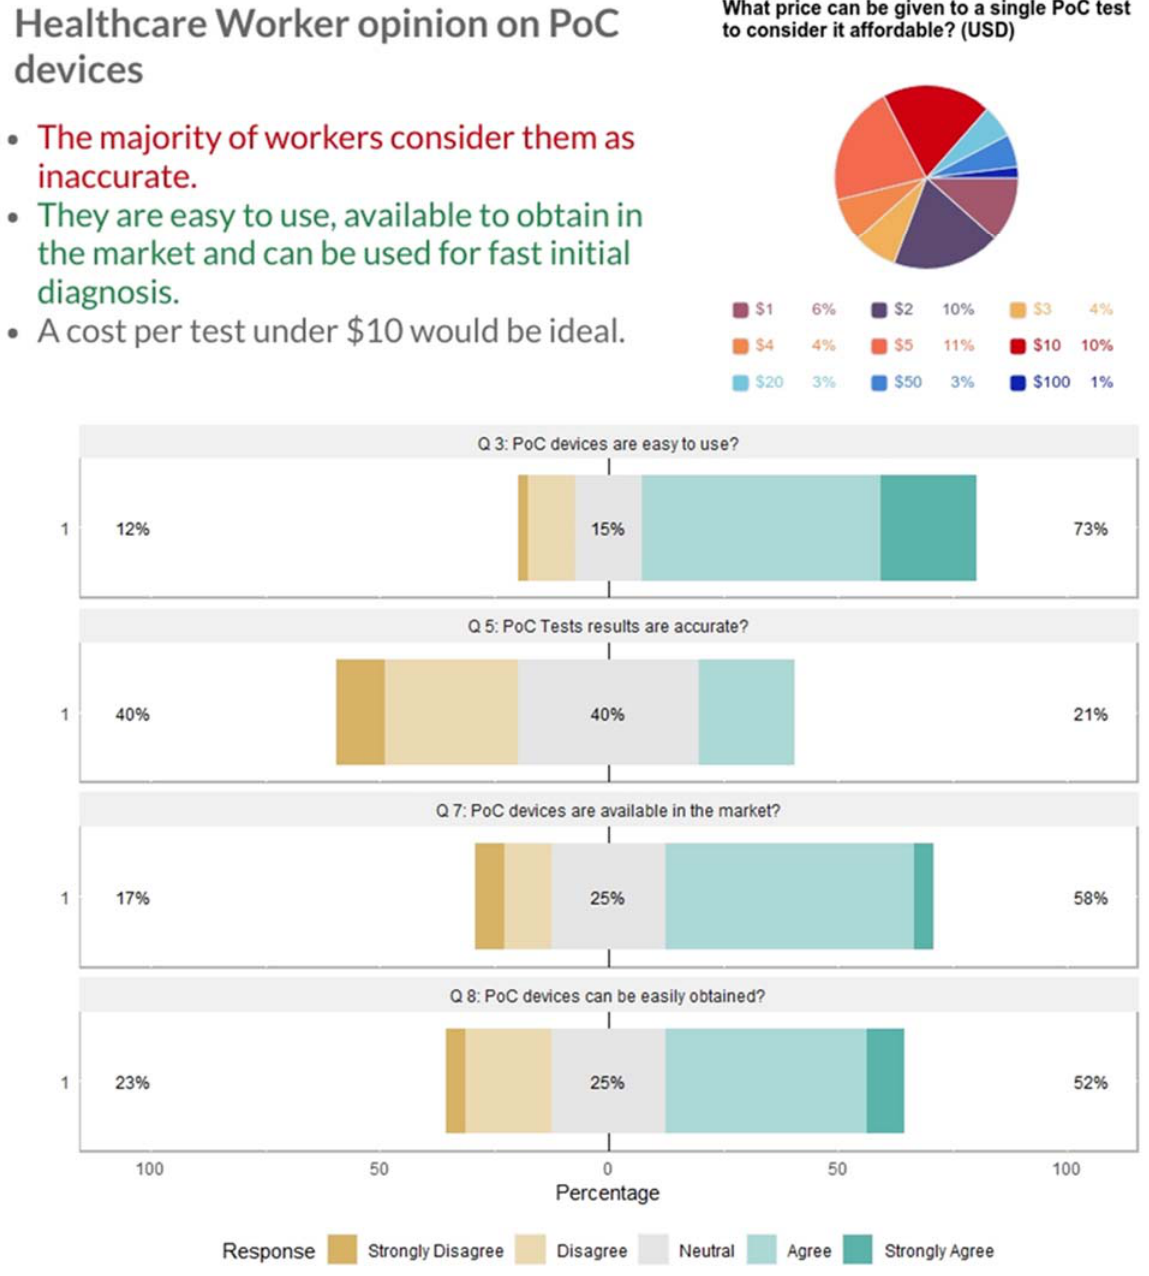
Figure 4. Range of the price of a single PoC test that makes it affordable as seen by the surveyed clinicians ( up ) and degree of agreement with the ease of use accuracy, availability, and accessibility of PoC devices ( down ). Summary statistics of each bar are shown as percentages.